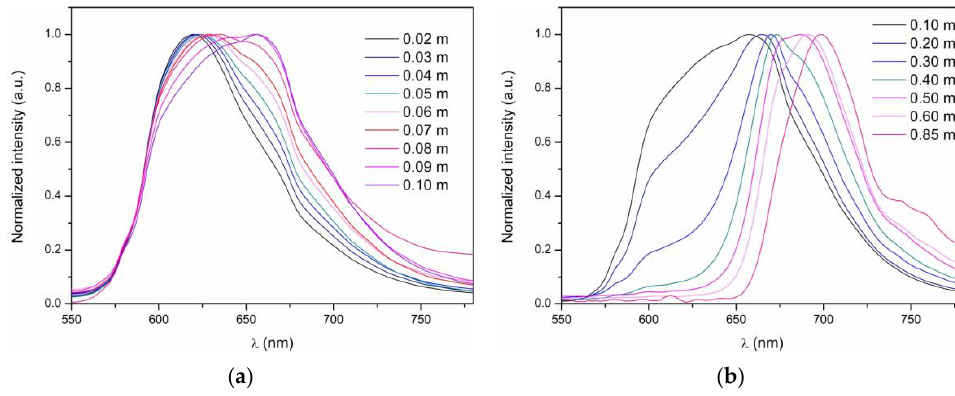
Figure 4. The normalized fluorescence spectra of Ox170 doped fiber: ( a ) 0.02–0.10 m, ( b ) 0.10–0.85 m. The full width at half maximum (FWHM) of recorded spectra is presented in Figure 5b. The